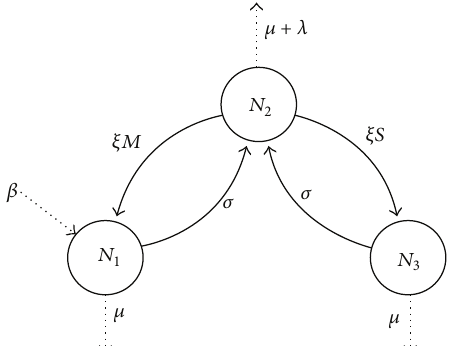
Figure 1: Schematic dynamics between female categories 𝑁 1 (repro- ductive stage after mating with a wild male), 𝑁 2 (ready to mate), and 𝑁 3 (reproductive stage after mating with a sterile male). 𝑀 and 𝑆 represent the density of wild and sterile males, respectively, 𝜇 is the death rate, 1/𝛽 is the average time a young female waits until its first mating encounter with a wild male, 1/𝜎 is the average time that a female spends gravid, 𝜆 is an additional mortality term, and 𝜉 represents the per capita average rate of mating